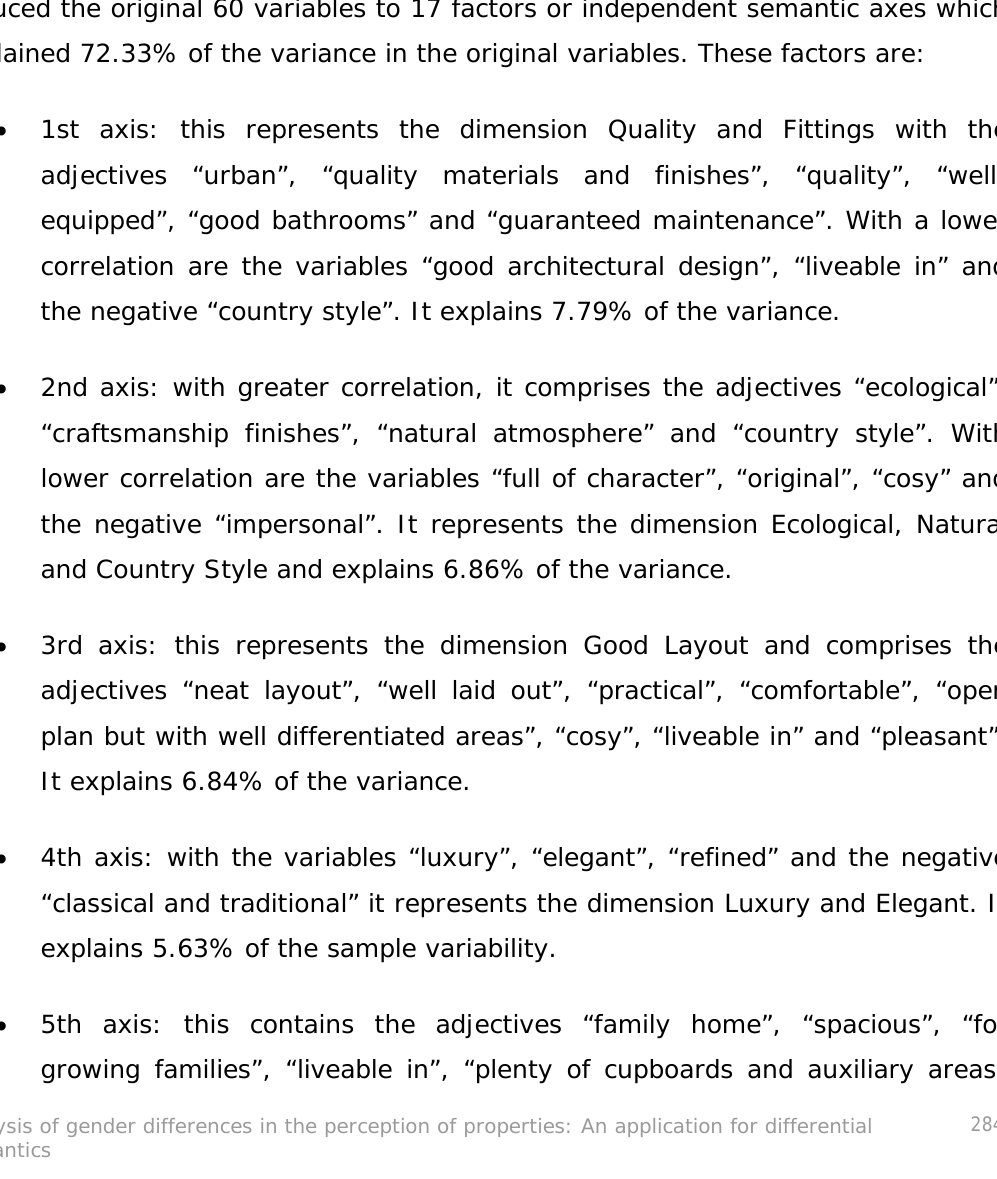
“classical and traditional” it represents the dimension Luxury and Elegant. It explains 5.63% of the sample